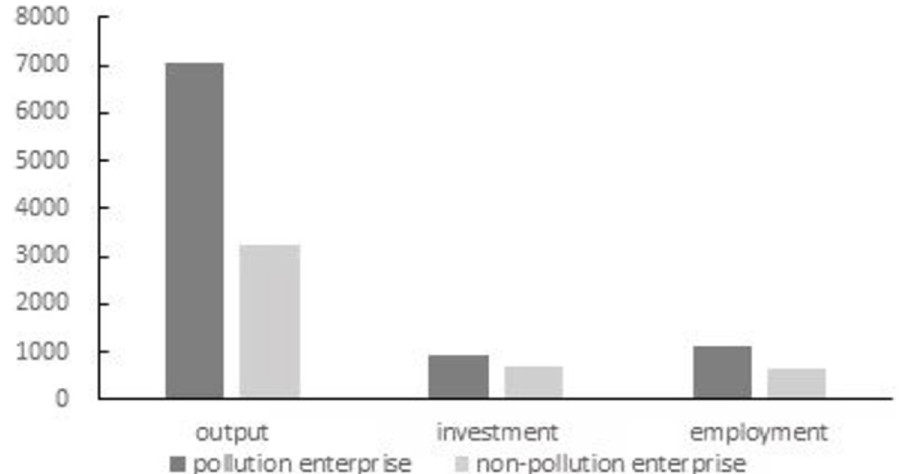
Fig 1. Average output, investment, and employment of enterprises of high-polluting and low-polluting industries. Note: The unit of output and investment is 10000 yuan, and the unit of employment is 100 people. We calculate the average output, employment, and investment of high-polluting and low-polluting enterprises based on the enterprise data in the ASIF.